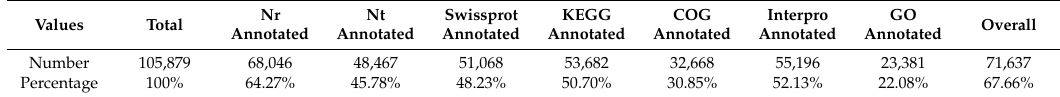
Table 1. Summary of the functional annotation results.